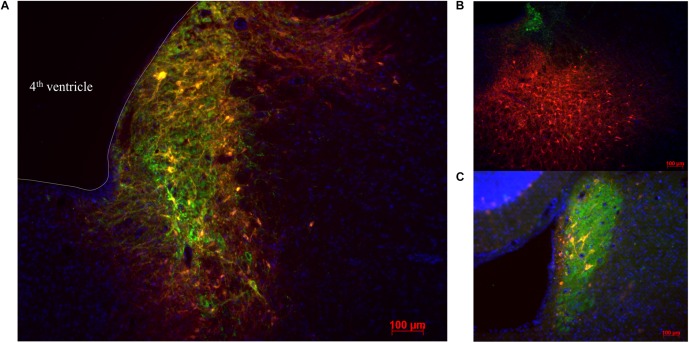
Visualization of hM3Dq-mCherry expression in LC injected with PRSx8-driven AAV. (A–C) LC-NA neurons are visualized using primary anti-DBH antibody (green) and expression of hM3Dq DREADD is visualized with the mCherry tag (red). (B) Aspecific hM3Dq expression (red) in DBH- non LC neurons. (C) Only a low number of transduced neurons are observed in some animals. Scale bar 100 μm.